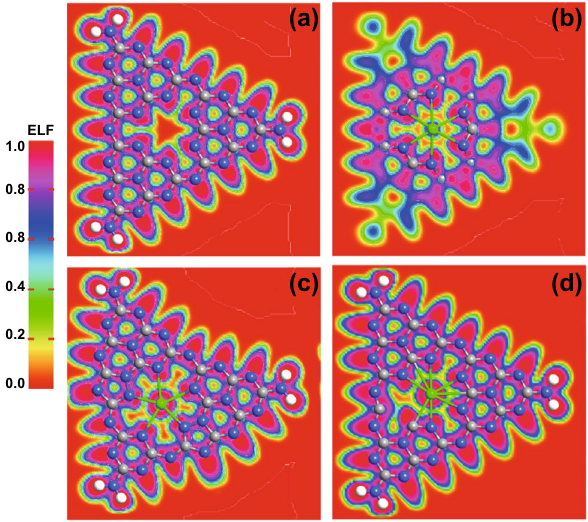
Fig. 6 Average electron density difference maps for a CN, b 0.15Sr- CN (Interstitial site) doping, c 0.15Sr-CN (C-substituted) doping, and d 0.15Sr-CN (N-substituted)